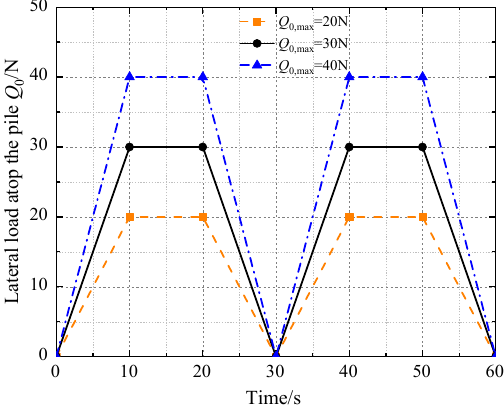
Figure 4. One ‐ way cyclic lateral loading path. Figure 4. One-way cyclic lateral loading